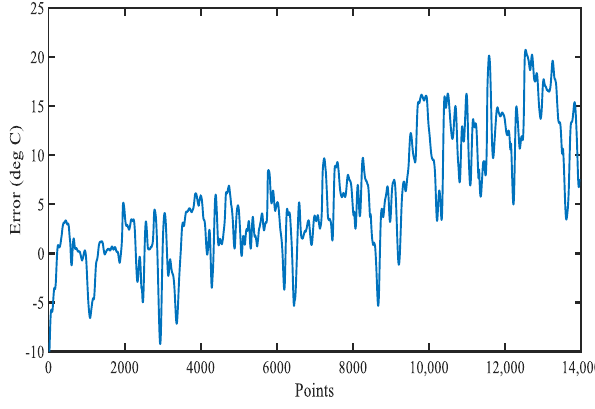
Figure 12. Residual temperature of the gearbox oil.